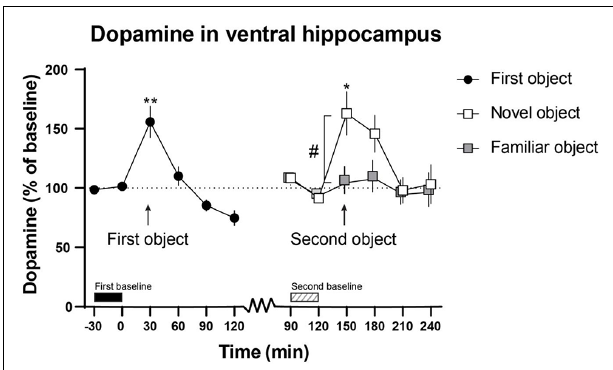
FIGURE 2 | The effect of the first novel and familiar object on dopamine output in the ventral hippocampus. The first object and the novel object enhanced dopamine output in the ventral hippocampus. Moreover, the novel object enhanced dopamine output compared with the familiar object. The first object was presented to the rats from 0 to 30 min and the second object from 120 to 150 min. The time points used for the first ( − 30 to 0 min) and second (90–120 min) baseline are shown above the x -axis. * p < 0.05, ** p < 0.01 vs. preceding baseline, # p < 0.05 between novel and familiar objects. All p -values were false discovery rate (FDR)-corrected for multiple comparisons. n = 13, six for novel object and seven for familiar object in the ventral hippocampus.